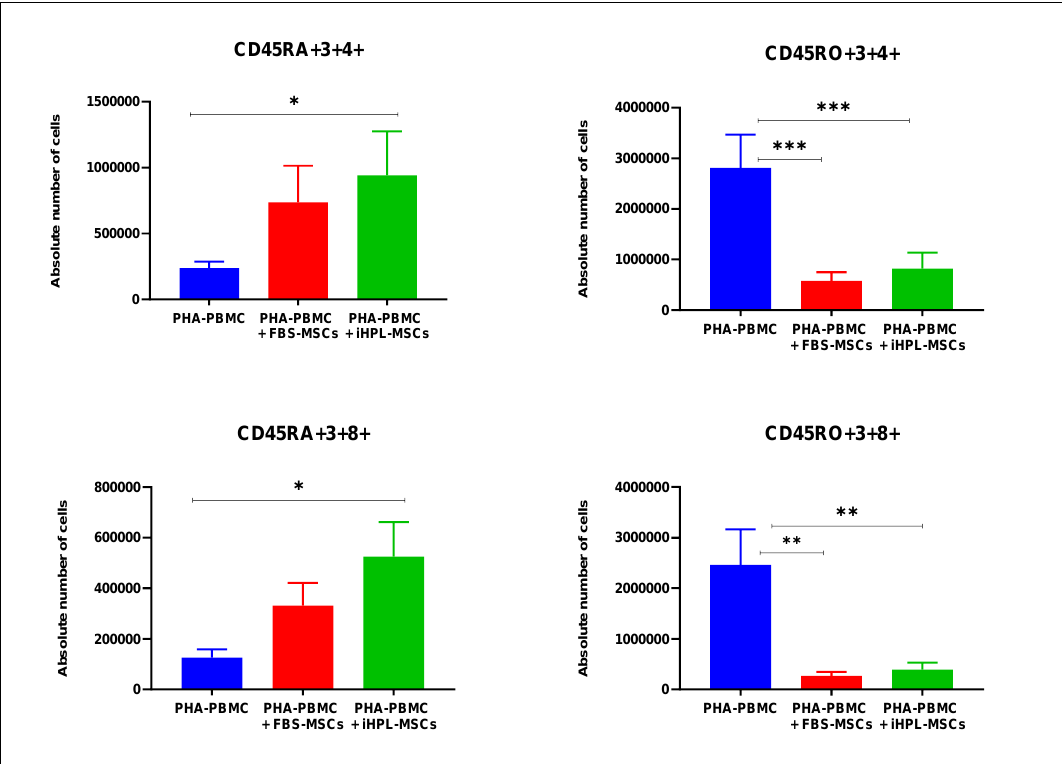
Figure 3. T subsets evaluated in phytohemagglutinin (PHA)-PBMC alone and in co-cultured conditions with FBS-MSCs and iHPL-MSCs, and expressed in mean values ± SEM. The symbols *, **, and *** indicate statistically significant differences with p < 0.05, p < 0.01, and p < 0.001, respectively.